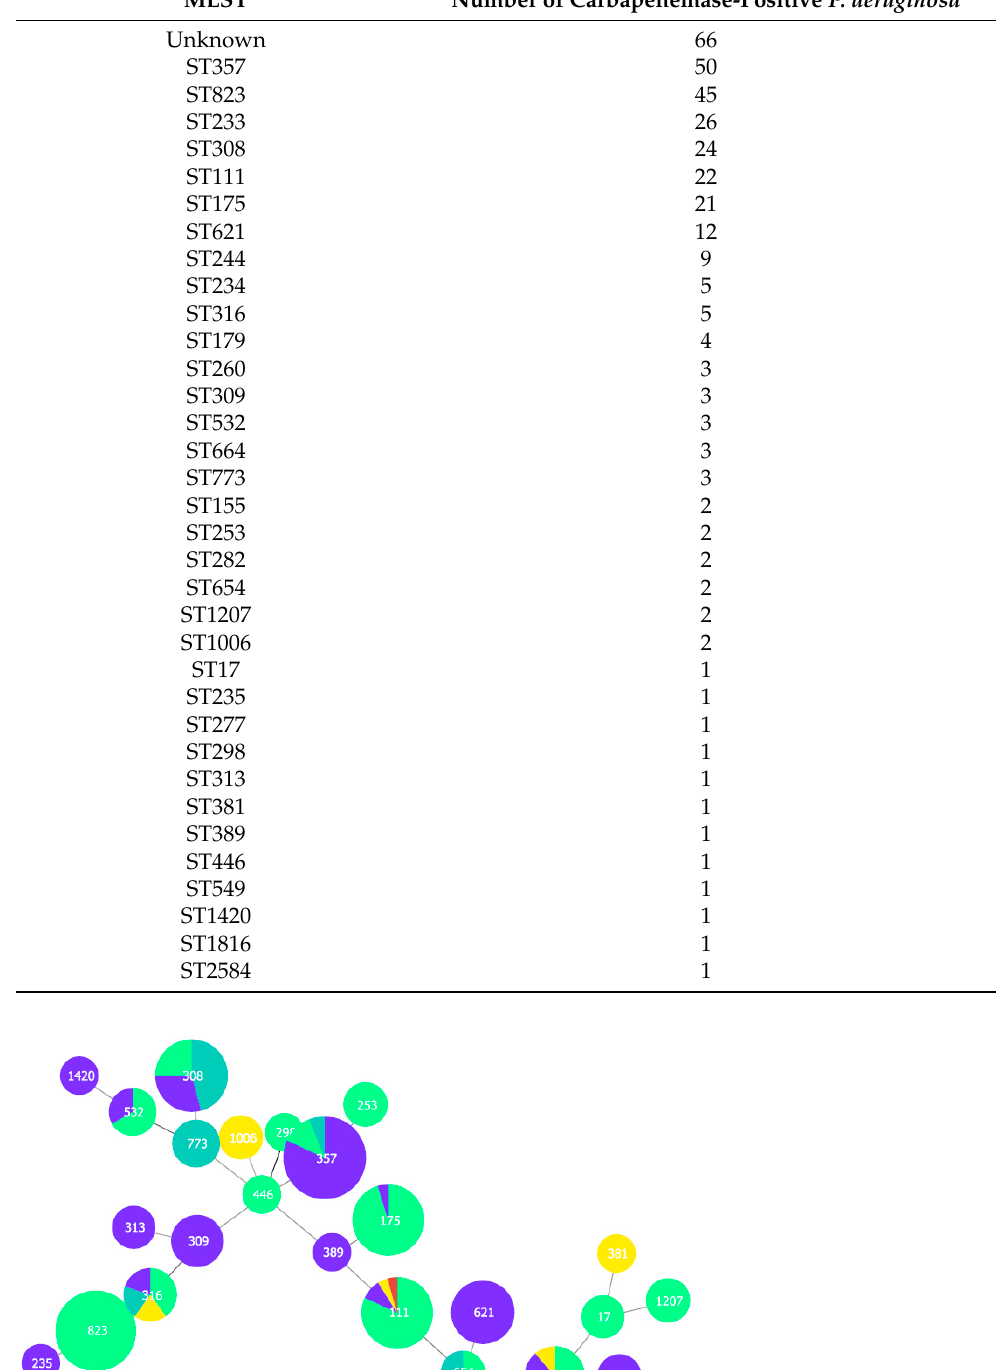
Table A4. The number of carbapenemase-positive P. aeruginosa of various MLST types. MLST Number of Carbapenemase-Positive P. aeruginosa